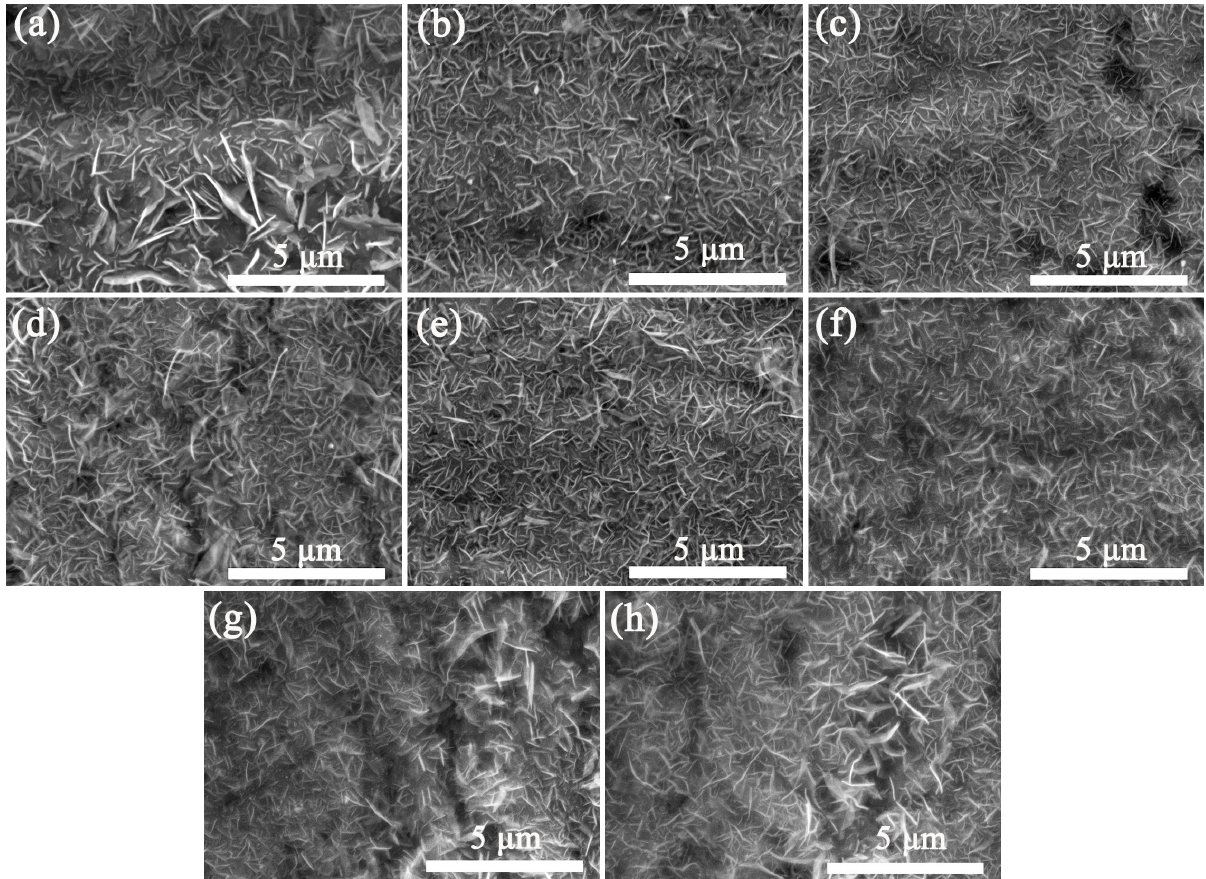
Figure 5. Effect of the spraying time of 0.4 g/mL precursor solution on the morphology and uniformity of VGNs/CF composite films at 850 °C: ( a ) 1, ( b ) 2, ( c ) 5, ( d ) 10, ( e ) 15, ( f ) 20, ( g ) 30, and ( h ) 40 times, respectively.